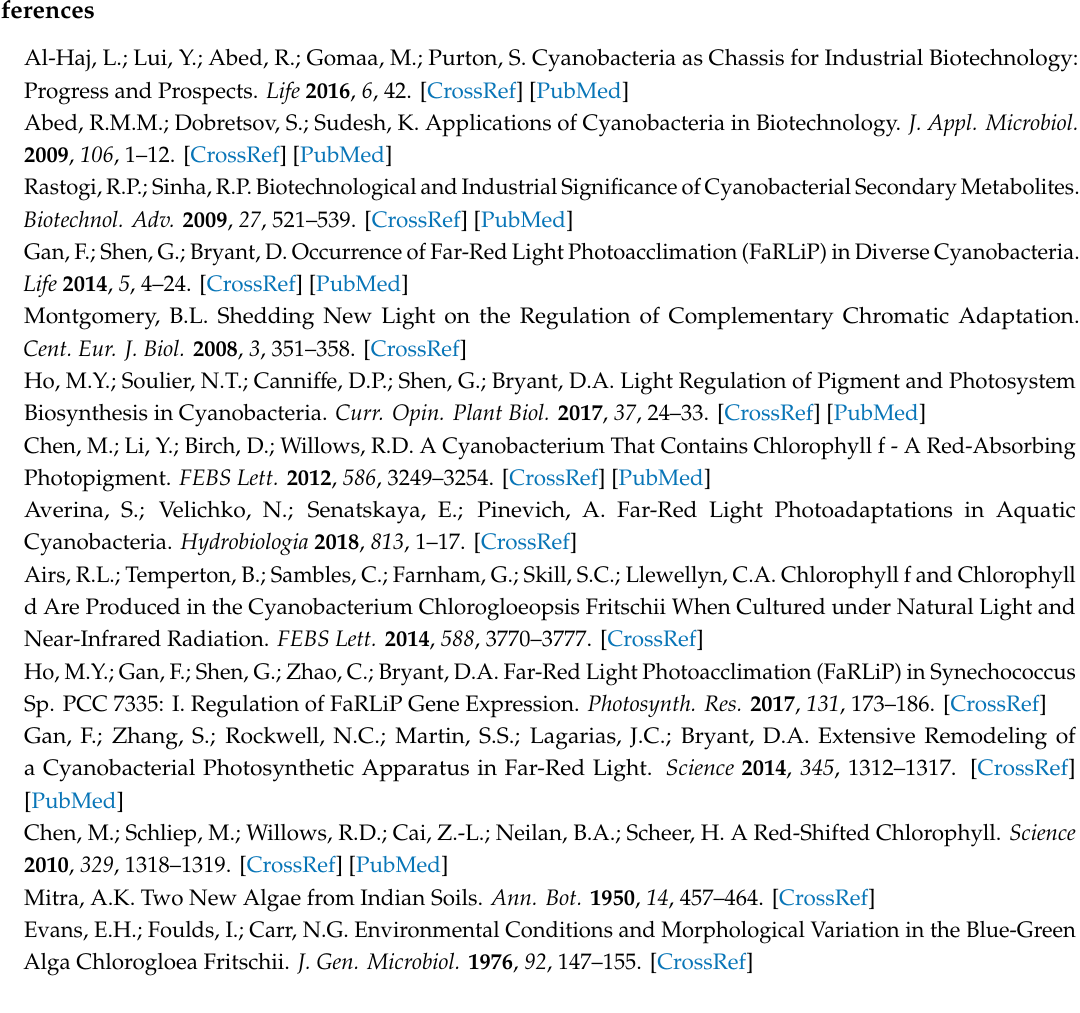
Table S1: Statistical analysis of composition of C. fritschii culture, Table S2: Bioactive compounds produced by Chlorogloeopsis